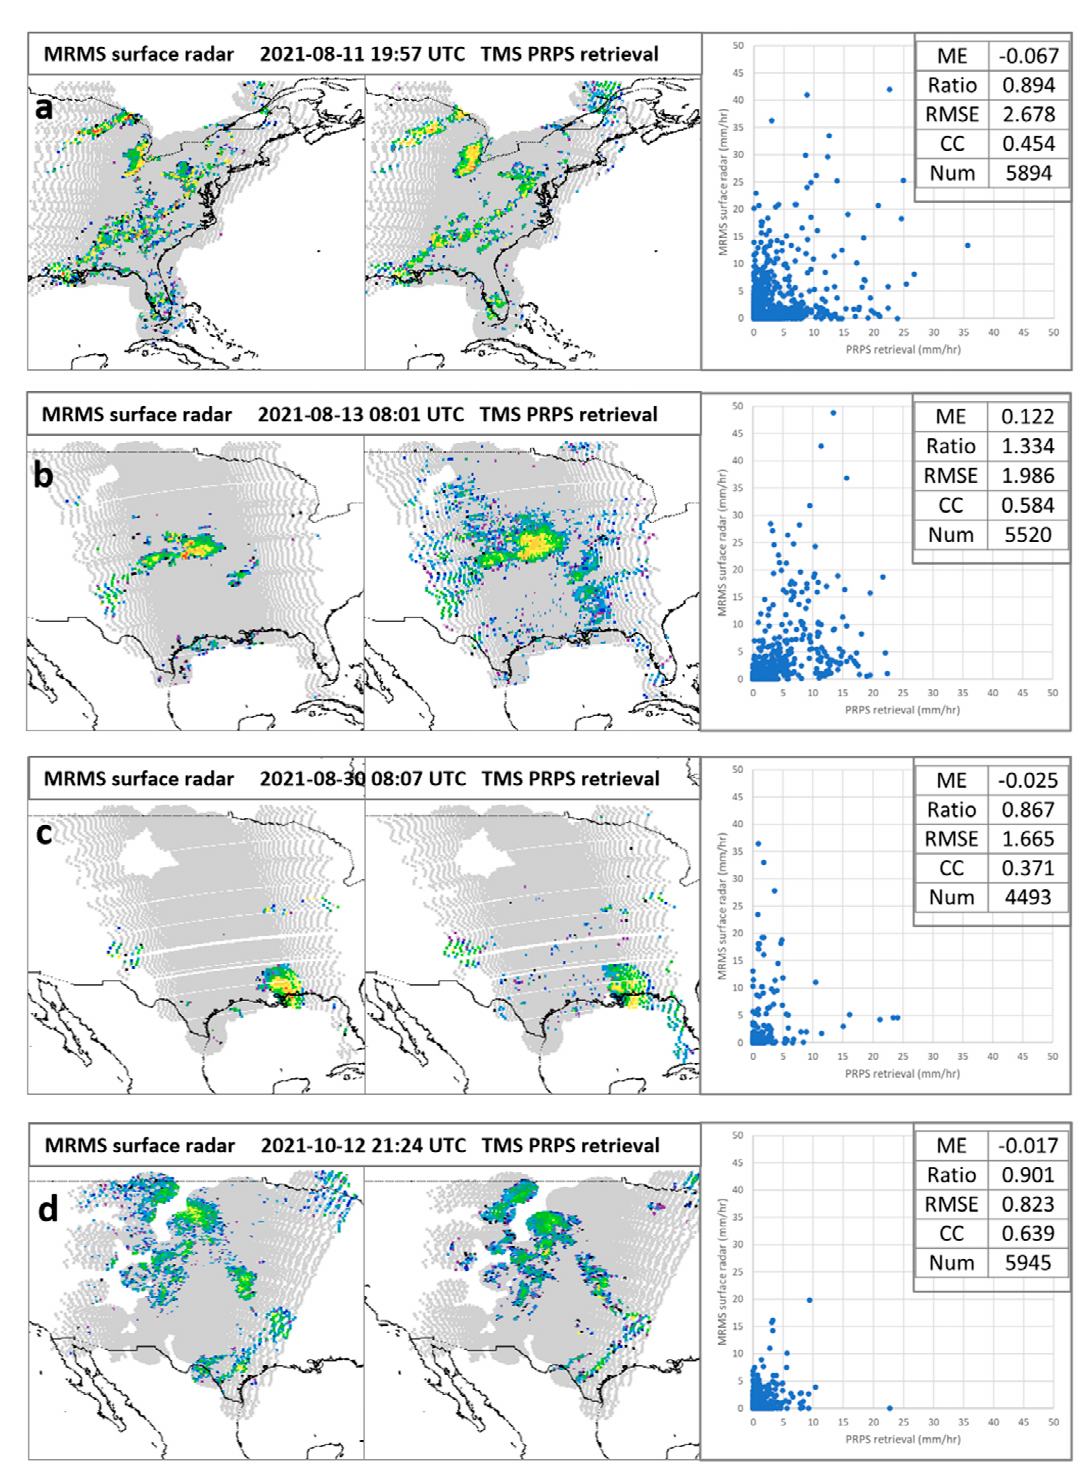
Figure 6. Comparisons of instantaneous MRMS surface radar ( left ) vs. PRPS–TMS retrievals ( right ) over the US for four case studies: ( a ) Appalachian precipitation system, ( b ) Midwest connective system, ( c ) Hurricane Ida, and ( d ) Rocky Mountain mixed-phase precipitation. The scatterplots and statistics are for 15 × 15 km resolution MRMS/PRPS–TMS matches over the coverage of the images. (ME = mean error, CC = correlation coefficient).